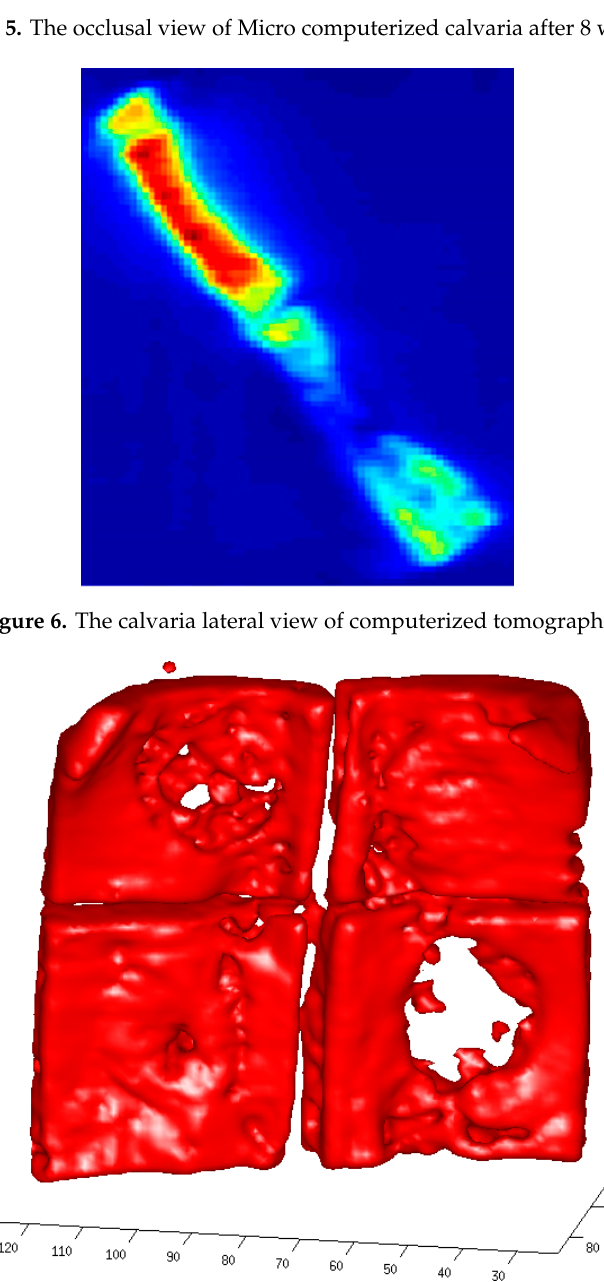
Figure 7. The occlusal view of Micro computerized calvaria at 8 weeks.